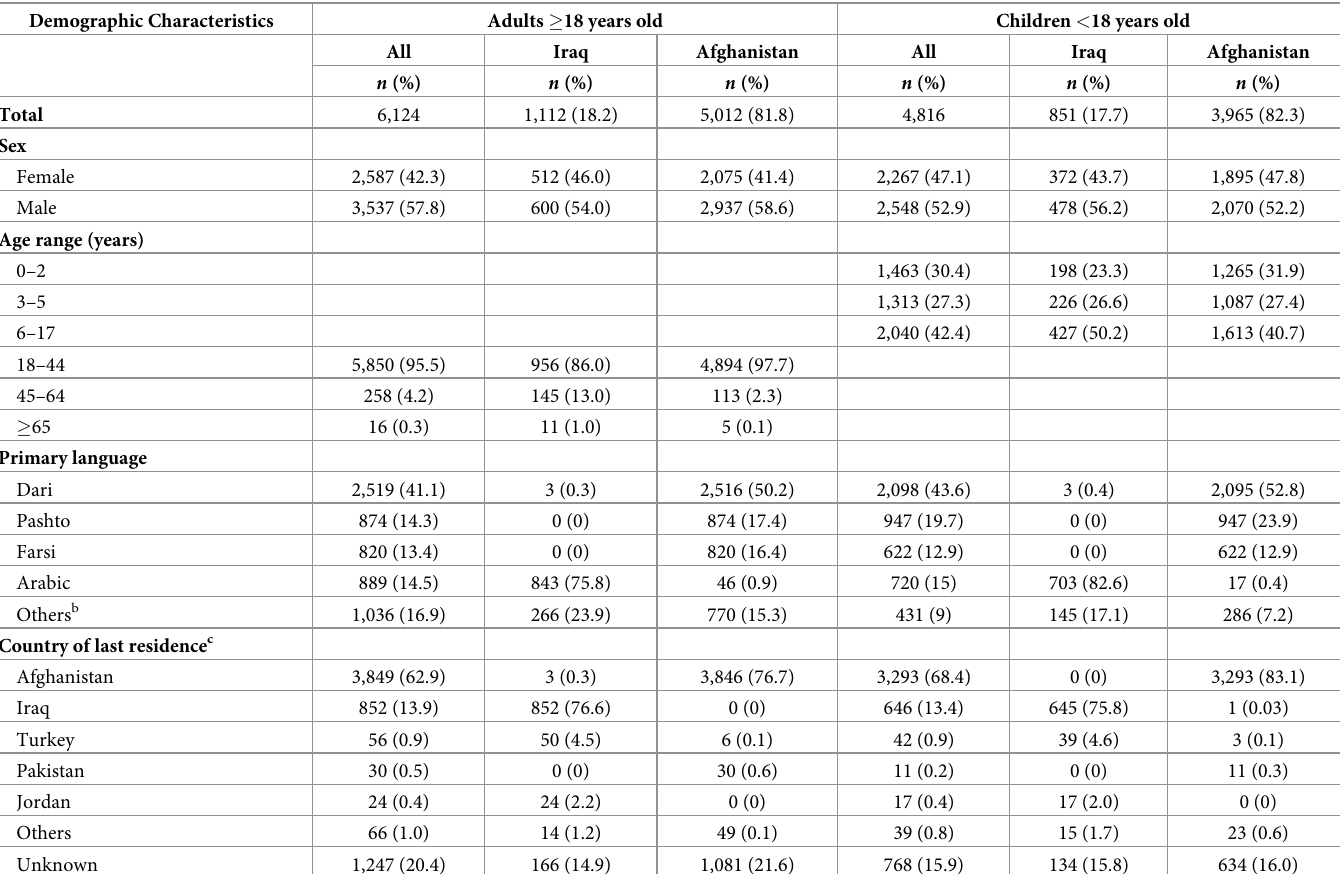
Table 1. Demographic characteristics of adults and children who resettled to the US with Special Immigrant Visas (SIV), 2014–2016 a . Demographic